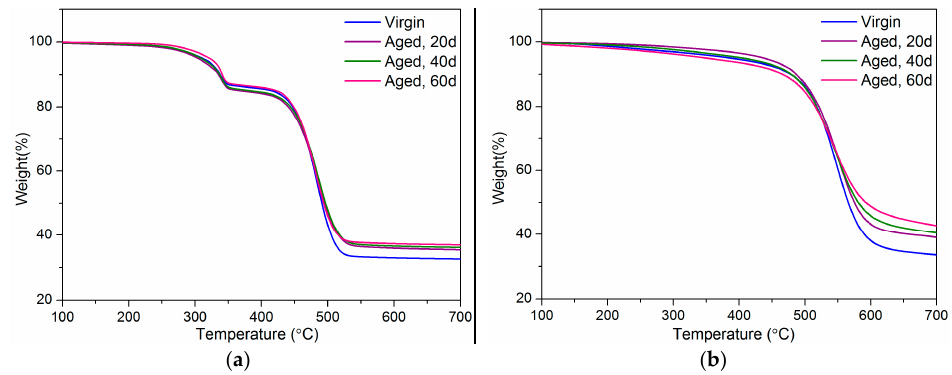
Figure 10. Thermogram of the decomposition of RTV silicone rubber samples before and after temperature cycling treatment. ( a ) Sample 1; and ( b ) Sample 2.